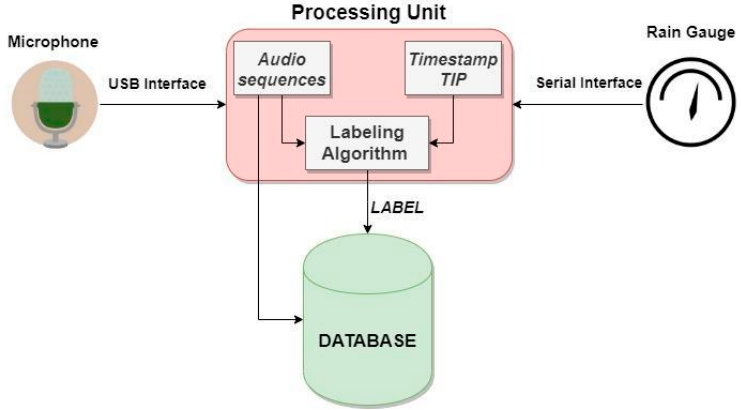
Figure 1. Audio acquisition system. Table 1. Rain classification and precipitation intensity range.